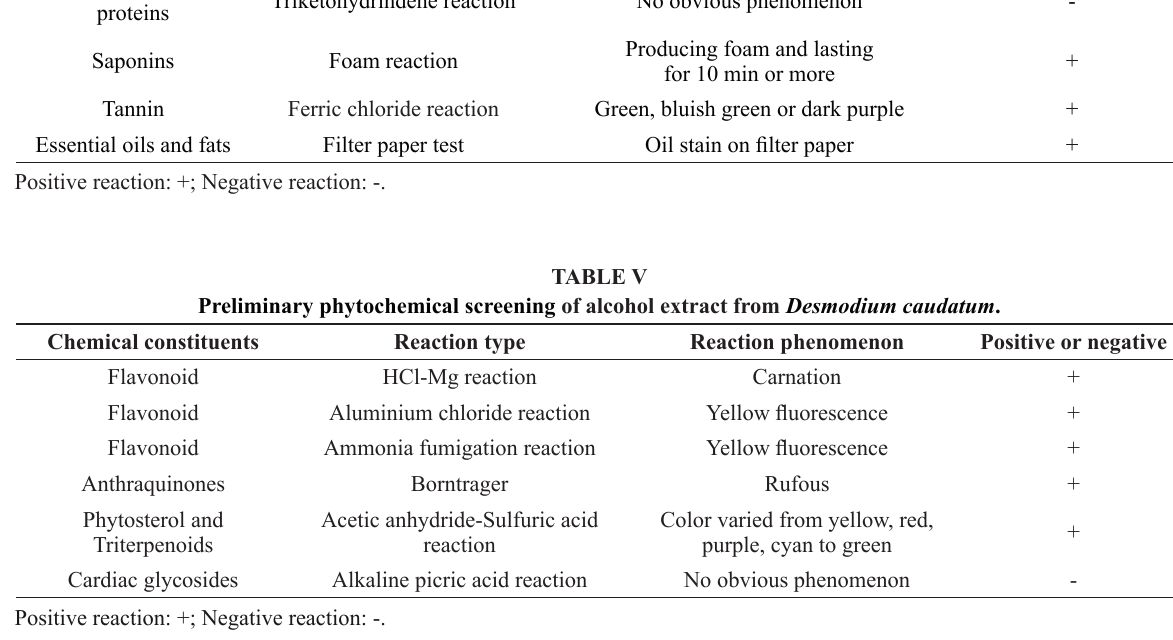
Positive reaction: +; Negative reaction: